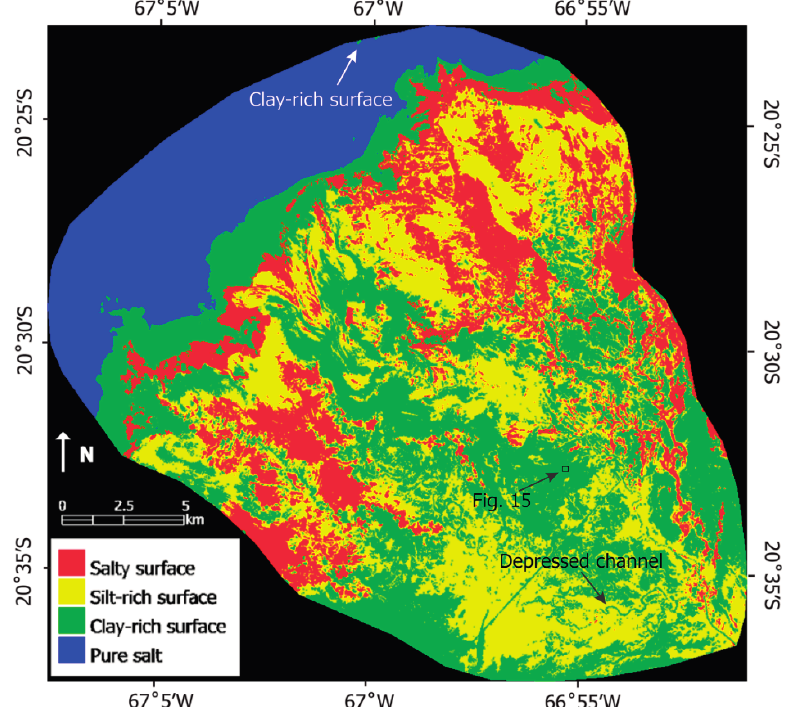
Figure 9. Classification map of Landsat TM on 20 October